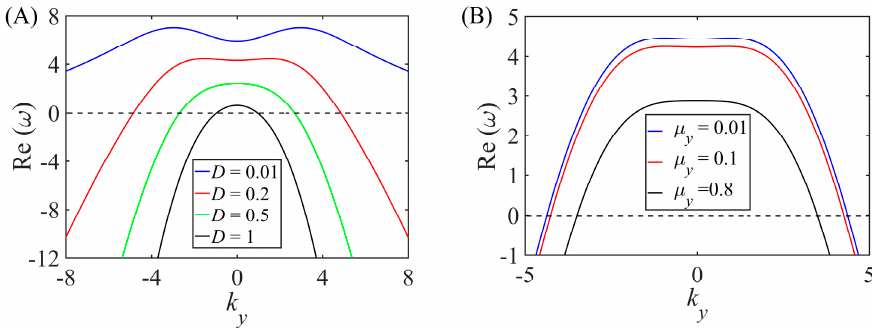
Figure 7. The growth rate for different ( A ) (cid:1830) and ( B ) (cid:2020) (cid:3052) versus (cid:1863) (cid:3052) for (cid:1863) (cid:3051) = (cid:1863) (cid:3051)(cid:2923)(cid:2911)(cid:2934)